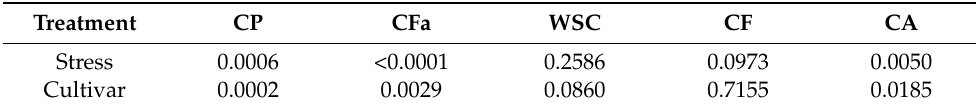
Table 2. Results ( p -values) of a two-way ANOVA on the effects of cold stress and cultivar treatments on the chemical composition of soybean seeds. Treatment